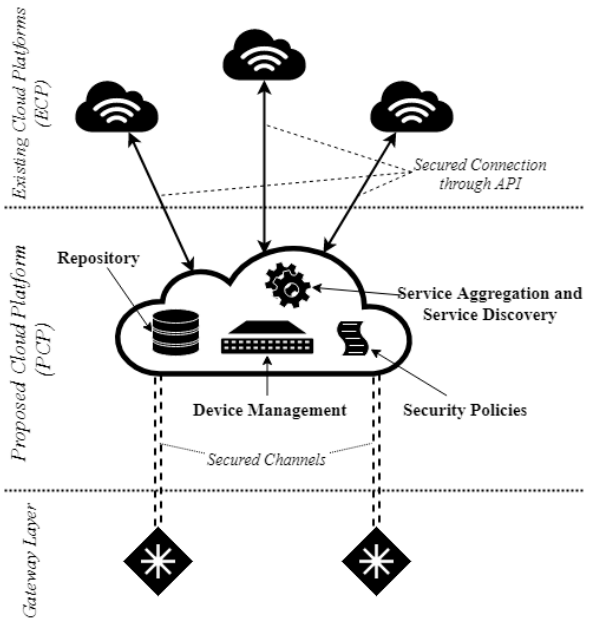
Figure 2. The architecture of the proposed Cloud platform.